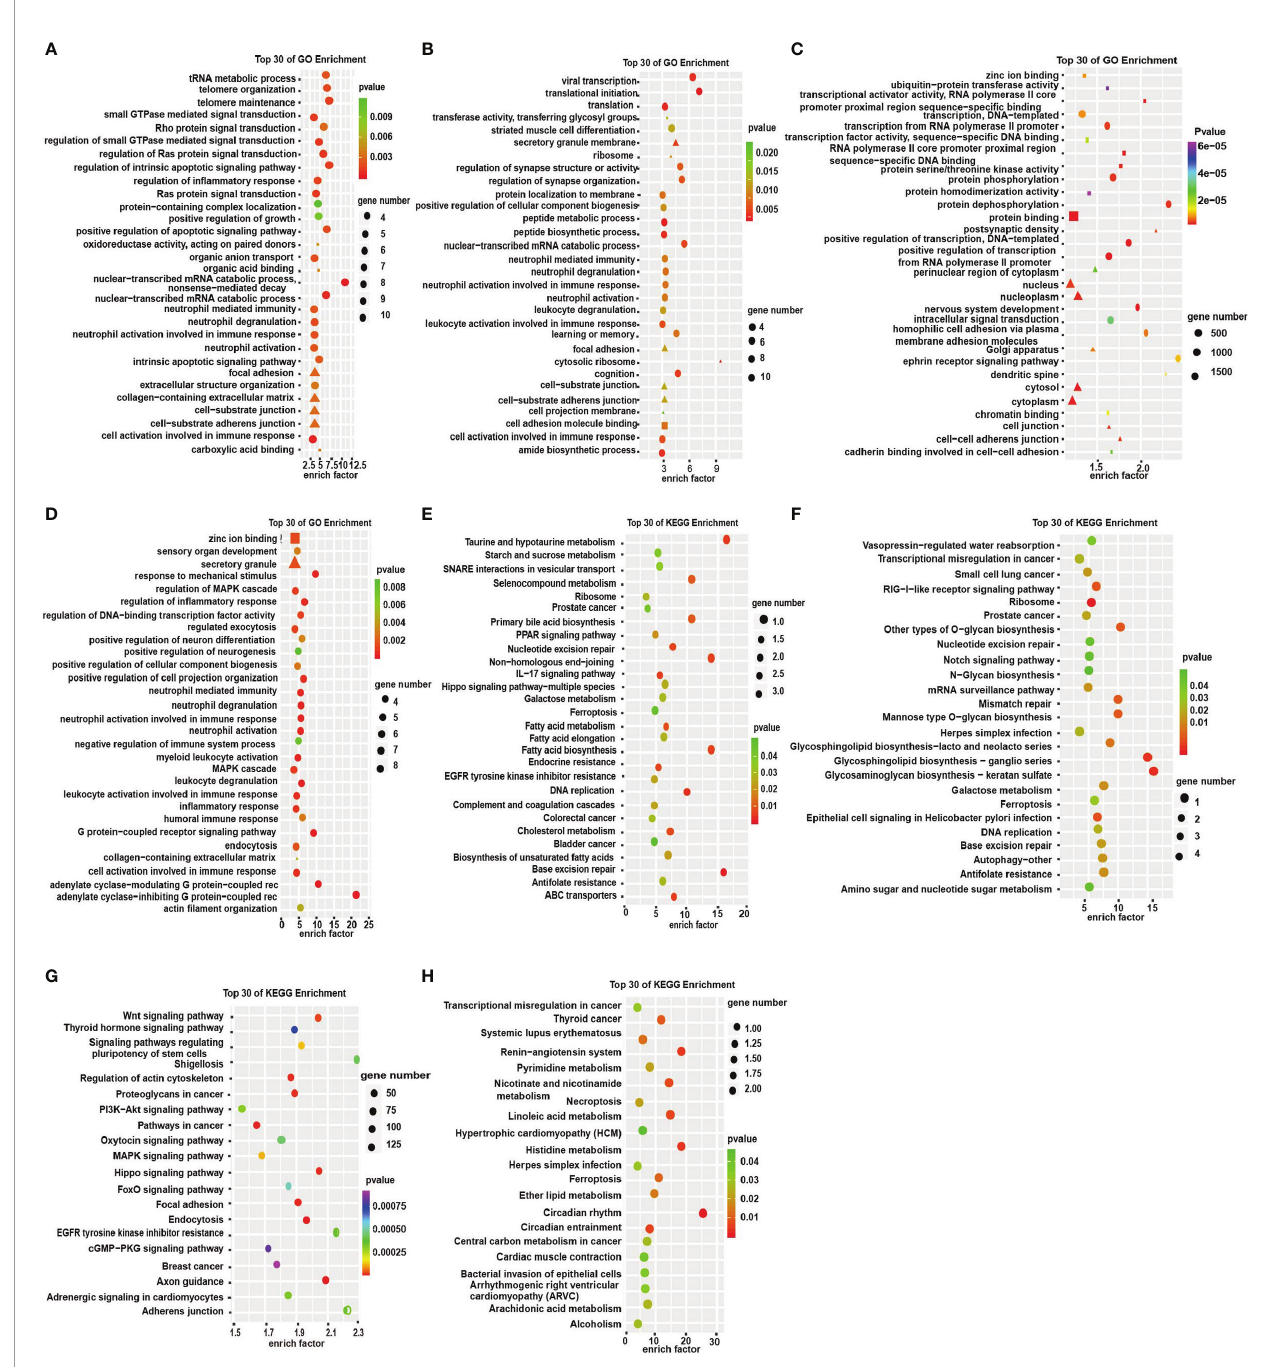
FIGURE 4 | GO enrichment analysis and KEGG pathway analysis in the signi fi cantly DEGs. (A – D) GO enrichment analysis of top 30 terms of molecular functions (MF: ■ ), cell components (CC: ▲ ), and biological processes (BP: ● ) of circRNAs, lncRNAs, miRNAs, and mRNAs, respectively. (E – H) Top 30 terms of KEGG signaling pathways of circRNAs, lncRNAs, miRNAs, and mRNAs